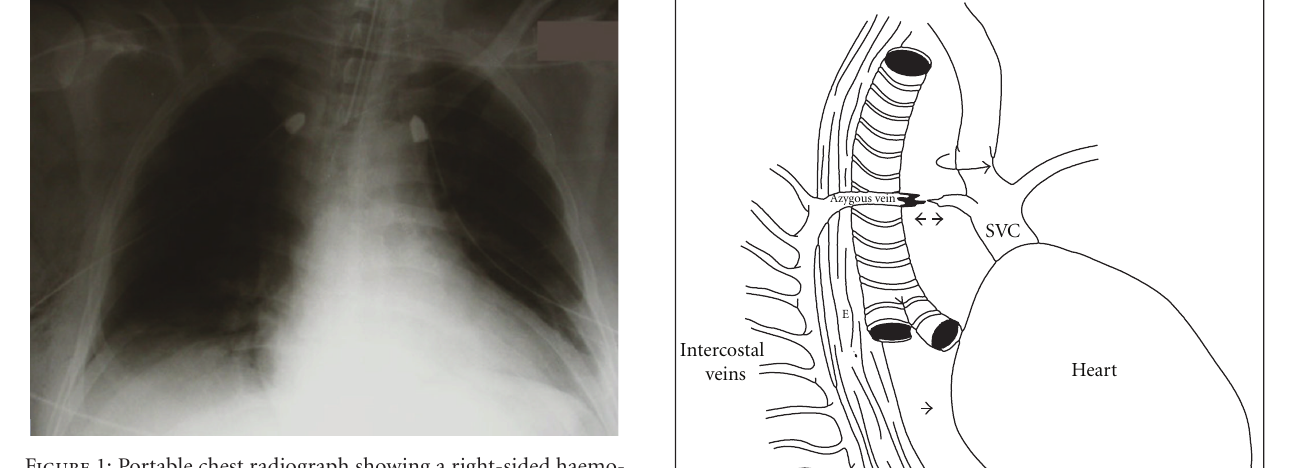
Figure 1: Portable chest radiograph showing a right-sided haemo- thorax and a widened mediastinum (bilateral chest drains inserted).